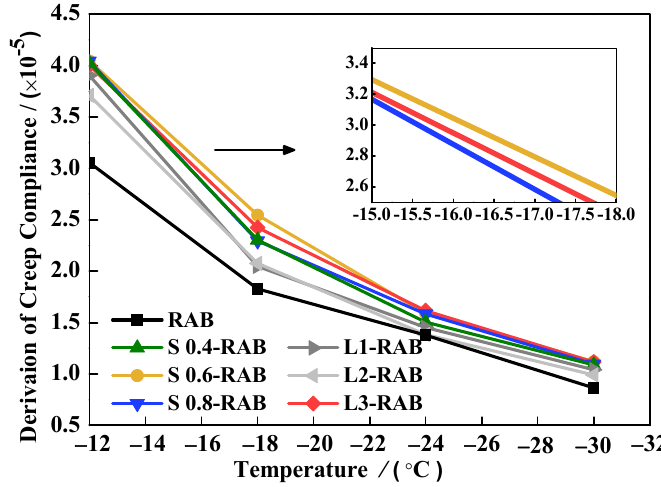
Figure 13. 𝐷 (cid:4593) (𝑡) values for W-RABs at 60 s. The damping ratio indicates the inherent resistance to deformation [32]. Equation (16) indicates that the damping ratio is the ratio of the loss modulus 𝐸 (cid:4593)(cid:4593) (𝑤) to the storage modulus 𝐸 (cid:4593) (𝑤) and is related only to the power 𝑎 , which indicates that it is only related to the 𝑚 -value. Figure 14 presents the damping ratio values for all W-RABs versus temperatures, calculated using Equation (16).